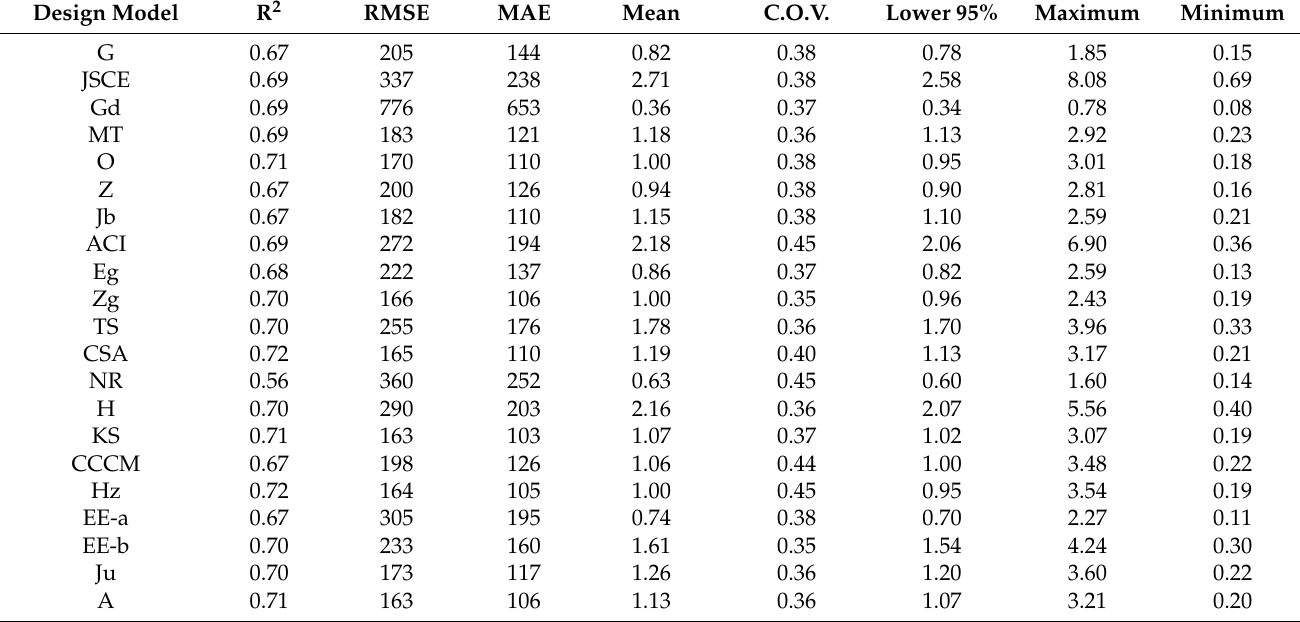
Table 3. Statistical measures for all strength